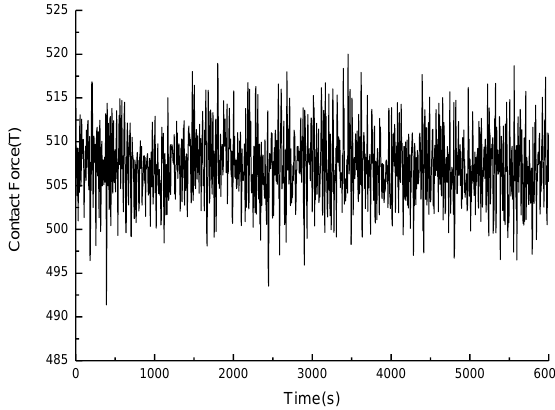
Figure 10. The curve of contact force during towing.